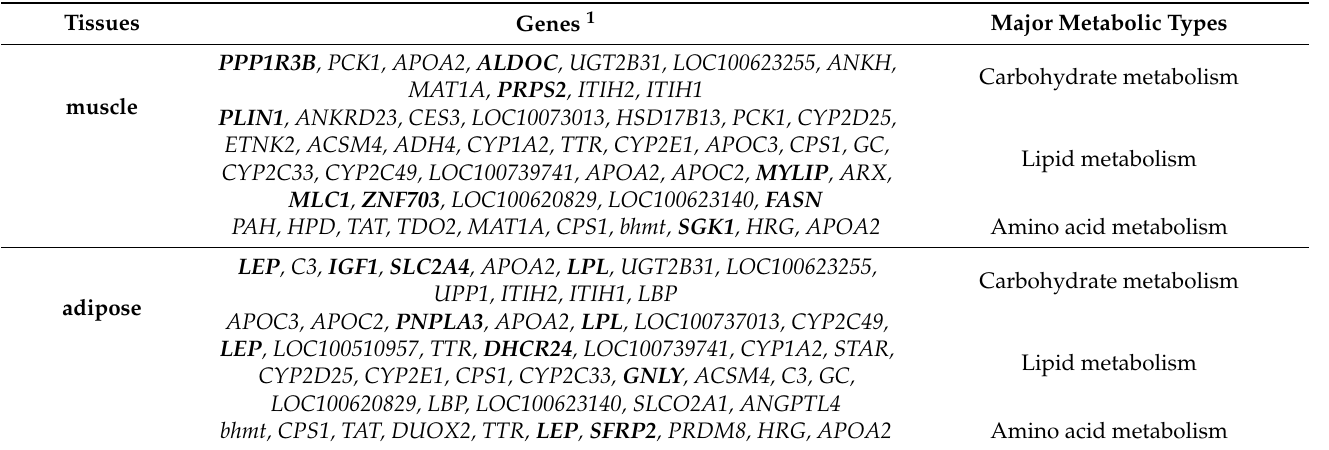
Figure 4. Protein-protein interaction (PPI) network for DEGs in the muscle ( A ) and adipose ( B ) tissues of pigs induced by the infusion of sodium butyrate. The PPI network is graphically displayed as nodes (genes or GO/KEGG terms) and edges (significant interactions among nodes). GO, Gene Ontology; KEGG, Kyoto Encyclopedia of Genes and Genomes. Table 1. Summary of DEGs associated with metabolism in muscle and adipose